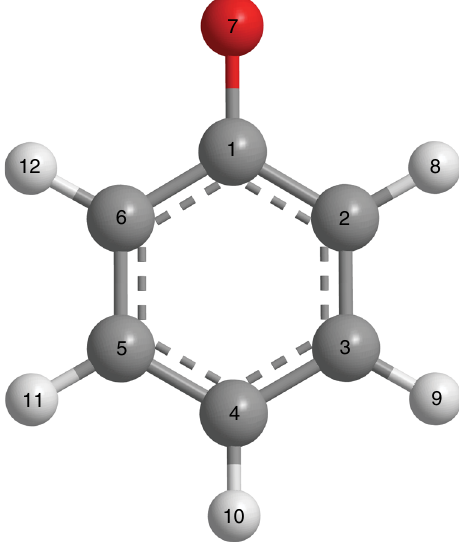
Fig. 1 Structure of the phenoxide molecule. The carbon atoms are in gray, the hydrogen atoms are in white, and the oxygen atom is in red